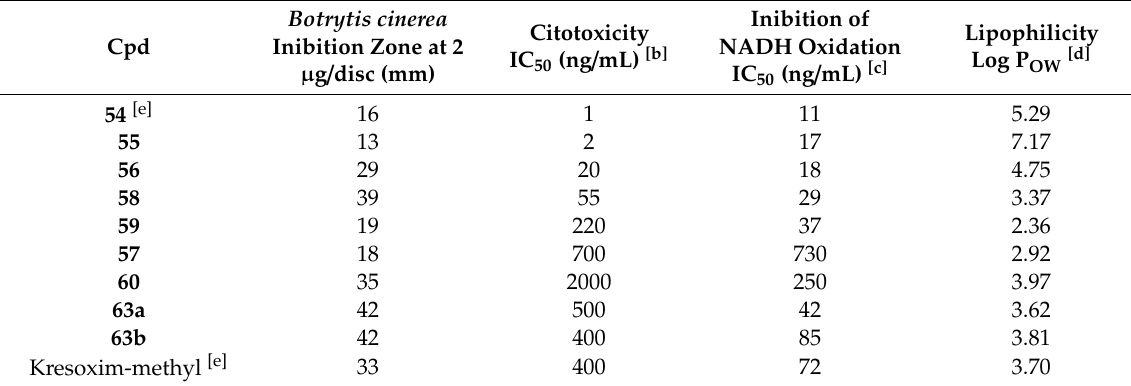
Table 7. Biological activities and lipophilicity of selected myxothiazol and melithiazol derivatives. [a]